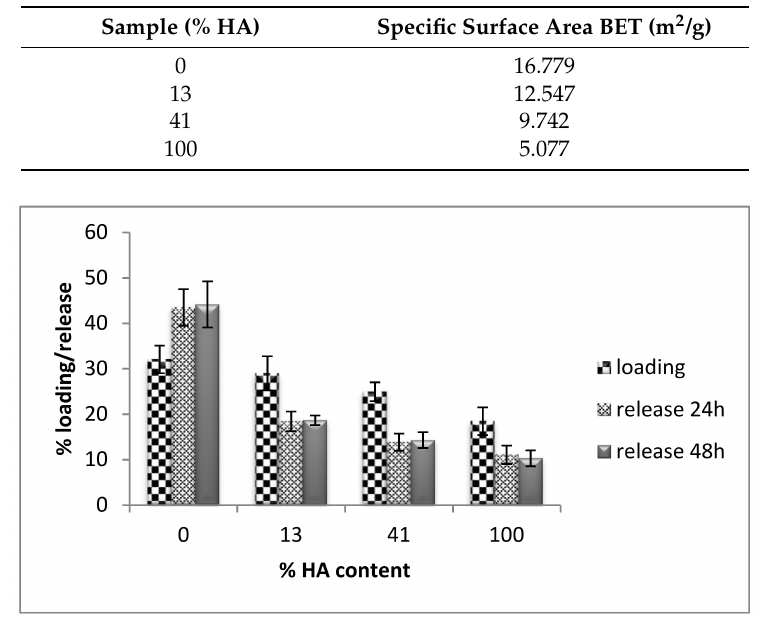
Figure 4. The percentage loading and release of curcumin on samples of 100% β -TCP, BCP (13% HA–87% β -TCP, 41% HA–59% β -TCP) and 100% HA. The results are mean ±